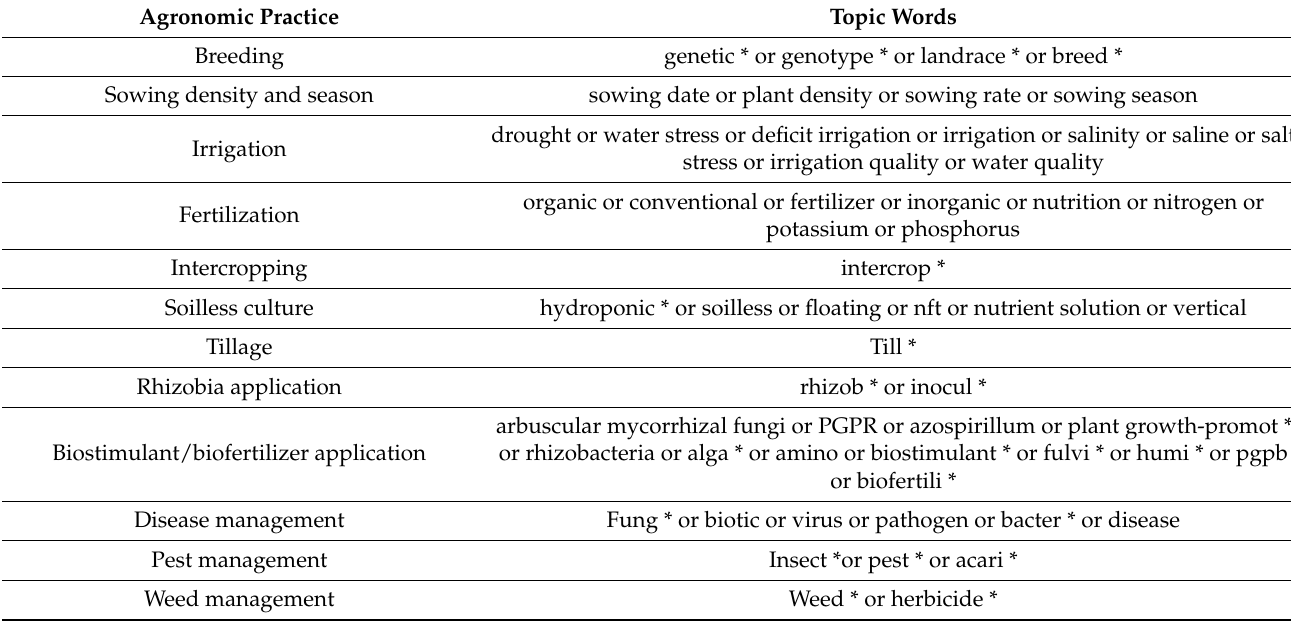
Table 1. Search scientific terms applied to the selected databases in terms of the agronomic practices. A wildcard (*) was used to enable the inclusion of multiple word